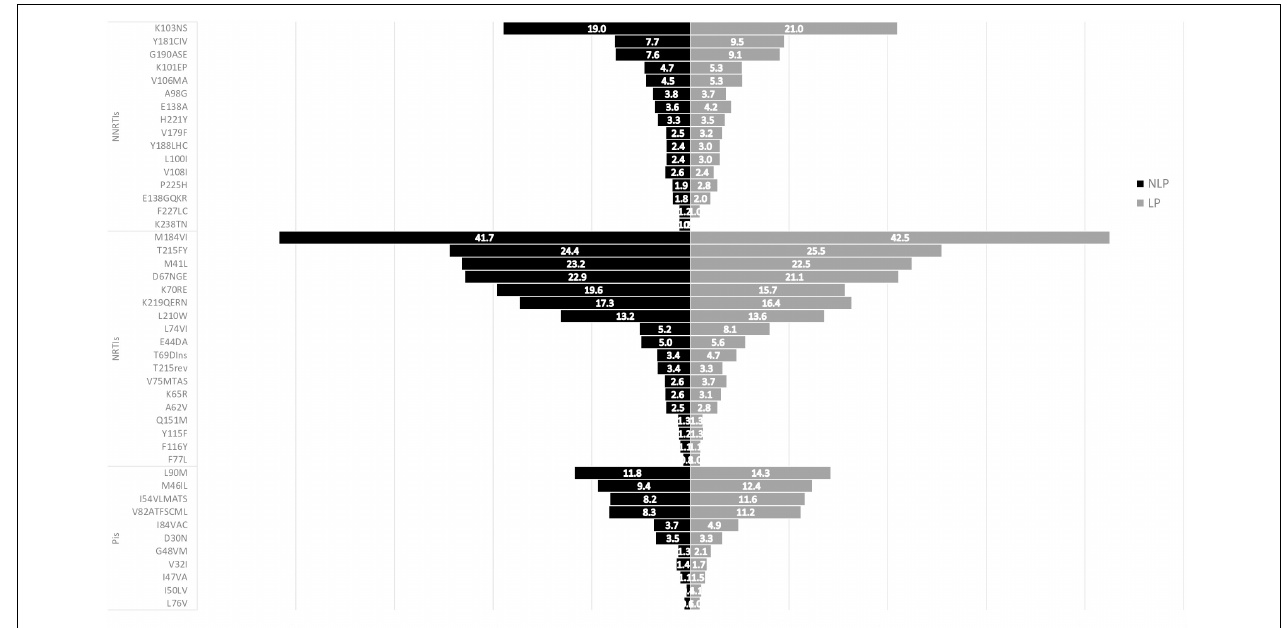
FIGURE 5 | ART-experienced mutations in Non-Late-Presenters (NLP) vs Late Presenters (LP). PIs, protease inhibitors; NRTIs, nucleoside reverse transcriptase inhibitor; NNRTIs, non-nucleoside reverse transcriptase inhibitor.